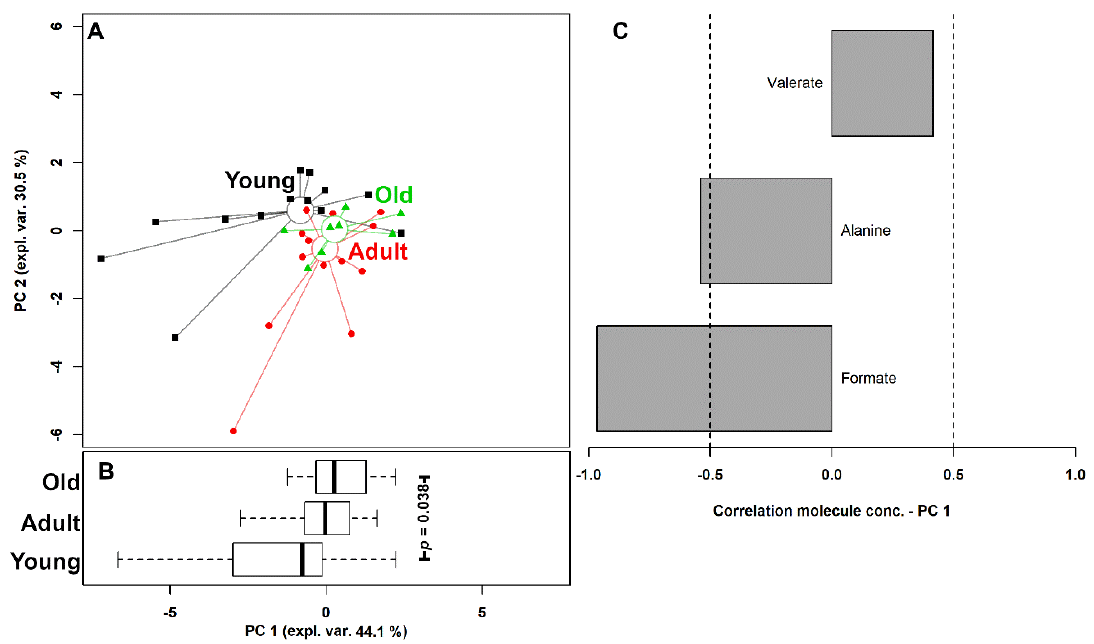
Figure 5. rPCA model of the concentration of the molecules showing a significant difference among the giraffes grouped by age. The scoreplot ( A ) shows the samples from the three groups with squares (Young), circles (Adult), and triangles (Old). The median of each sample group is represented by wide circles. The boxplot ( B) summarizes the positions of the samples along PC1 and compares them by two-way ANOVA, followed by Tukey post-hoc test. The loading plot ( C ) reports the correlation between the importance of each substance over PC 1 and its concentration. Gray bars highlight significant correlations ( p < 0.05).